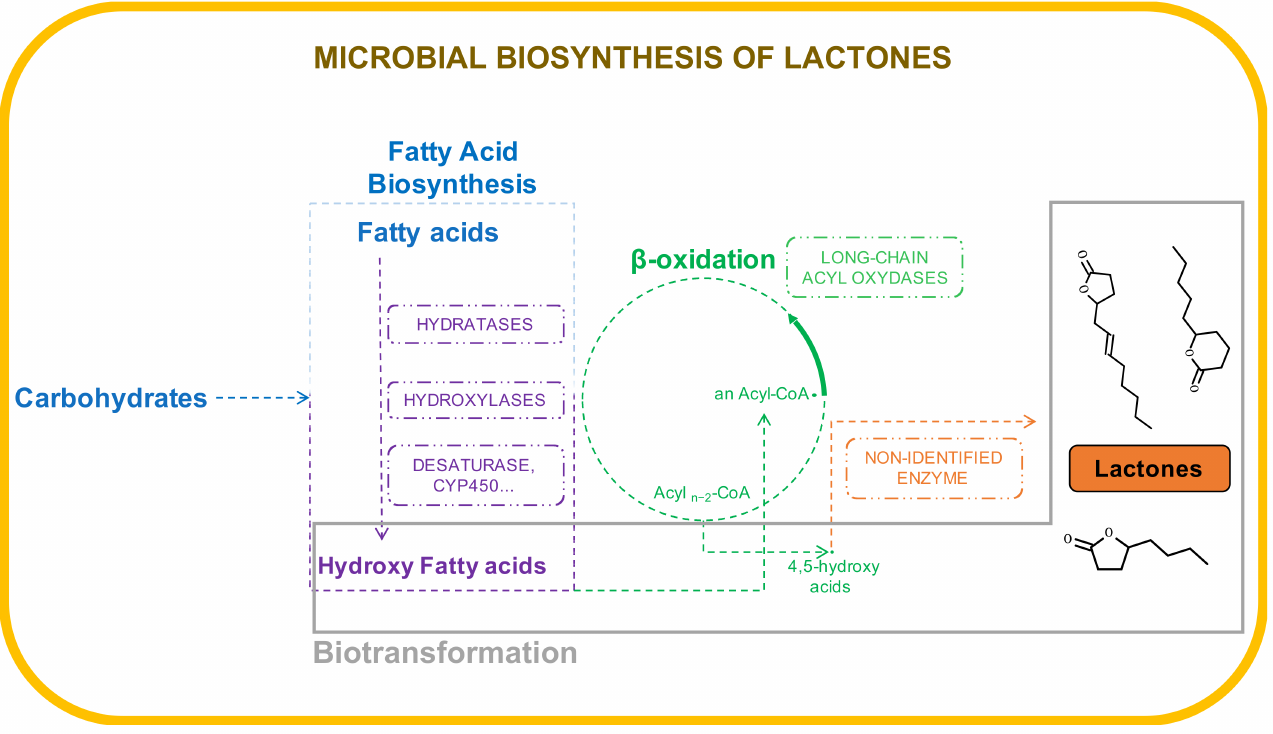
Figure 2. Schematic representation of microbial biosynthesis of γ - and δ -lactones. Overview of the different stages: biosynthesis of fatty acids (blue); formation of hydroxy fatty acids (purple); β -oxidation (green); and lactonization (orange). Traditional biotransformation processes are indicated by a grey box. Dashed boxes represent the most relevant enzymatic activities for improvement of lactones